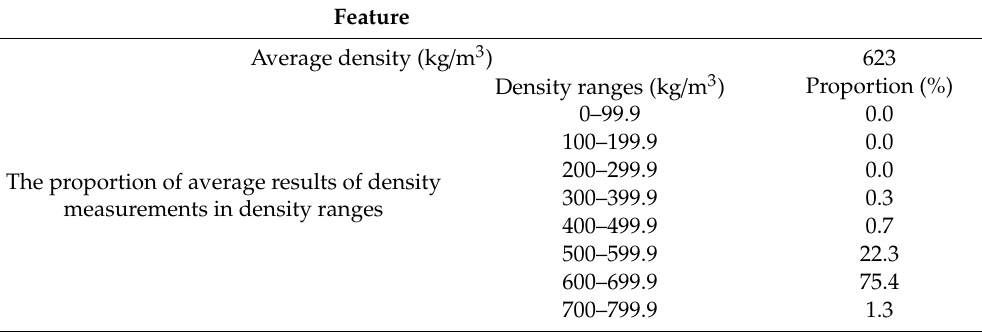
Table 13. Proportion of density measurement results in density